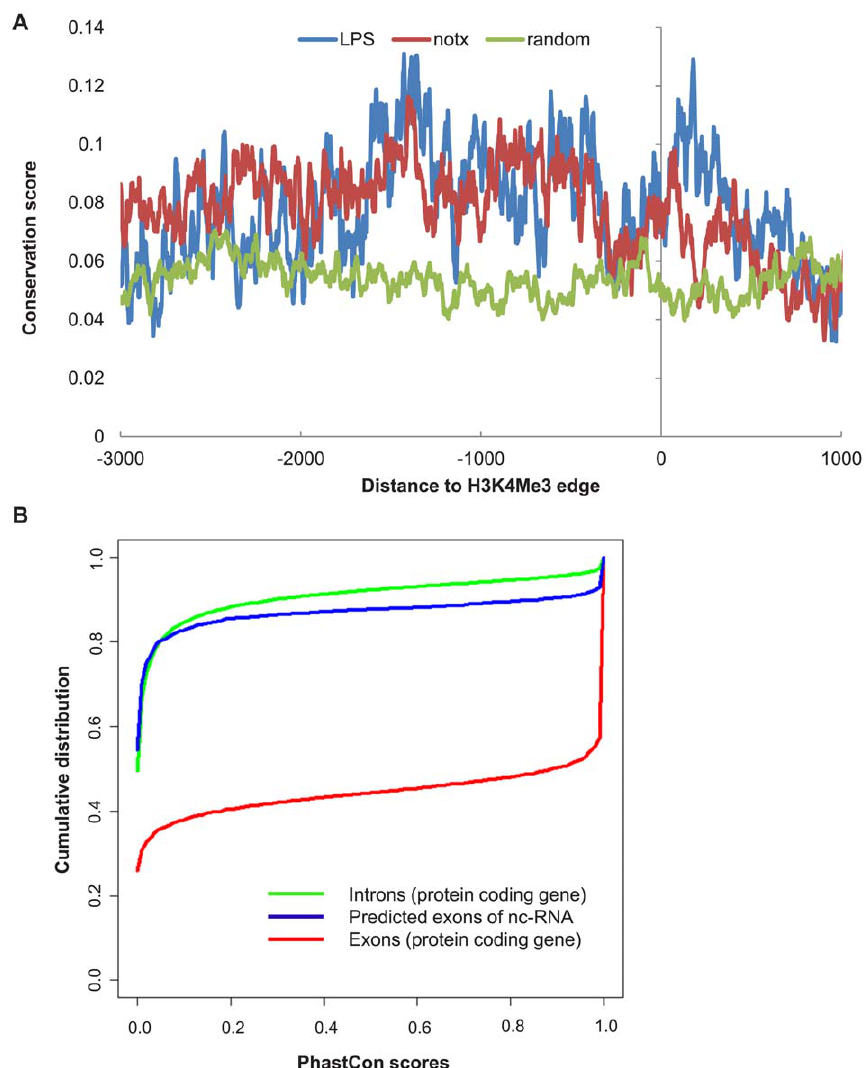
Figure 5. Conservation in lincRNA. A: conservation in the promoter region of lincRNA. The promoter region is defined as 2 3 K to 1 K relative to TSS that is labeled by the 3 9 edge of the H3K4Me3 peaks. Averaged phastCon scores are used as measurements of conservation. Random intergenic sequences without evidence of lincRNAs are plotted as the control. Both LPS and no-treatment have significant higher phastCon scores than the random sequence (Wilcoxon tests, P-value , 1e-15). B: conservation of predicted exons of lincRNA, in comparison to the introns and exons of protein coding genes. The accumulative fractions of phastCon scores are plotted against the phastCons. The predicted exons of lincRNAs are modestly conserved compared to the introns of protein coding genes, but are much less conserved compared to the exons of protein coding genes.